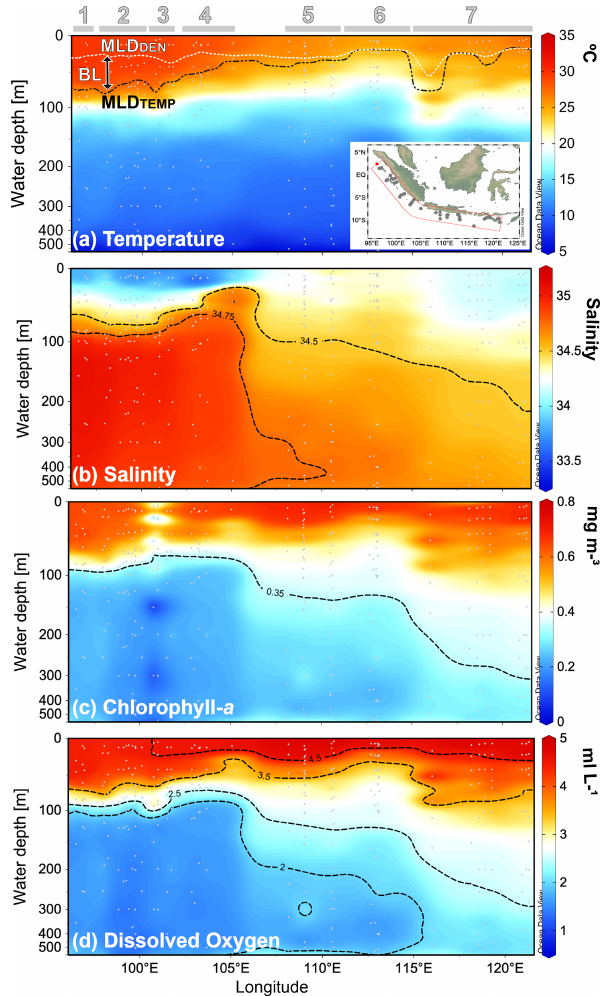
Figure 2. Cross-sections of (a) water temperature, (b) salinity, (c) chl a , and (d) oxygen content of the upper 500m of the wa- ter column during the sampling period. Location of the stations comprising the cross-section are depicted in the inset of (a) . Ther- mal mixed-layer depth (MLD TEMP ), density mixed-layer depth (MLD DEN ), and barrier layer (BL) are marked in (a) . Numbers and horizontal lines on top show each transect (1 to 7). Visualization is based on Ocean Data View 5.2.1 (Schlitzer,